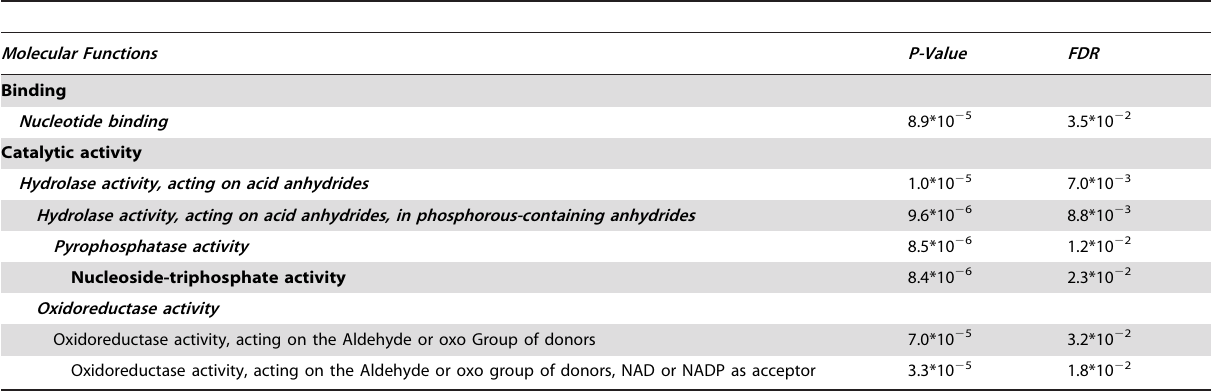
Figure 1. Venn diagram describing the proportion of proteins detected in never and current smokers. The circles represent proteins detected in at least one sample. A total of 859 proteins were detected by LC-MS/MS in any sample. 652 proteins were detected by LC-MS/MS in any never smoker, and 613 proteins were detected in at least one current smoker. The inner oval represents proteins detected by LC-MS/MS in the majority of samples. 197 proteins were detected in the majority of never smokers, and 169 proteins were detected in the majority of current smokers. *A total of 23 proteins differ between never and current smokers based on the criteria described in the methods. doi:10.1371/journal.pone.0005043.g001 epithelium carcinoma associated protein precursor (PLUNC, protein (NP_054752) was also detected in four never smokers and NP_570913), a secretory protein in the upper respiratory tract absent in all current smokers (P Fisher = 0.048). was detected in four never smokers and absent in all current Due to the small sample size, a second list of differentially smokers (P Fisher = 0.048). Hypothetical protein DKFZP586A0522 detected proteins was defined using a qualitative criterion: proteins Table 2. Enriched functions in the never smoker airway